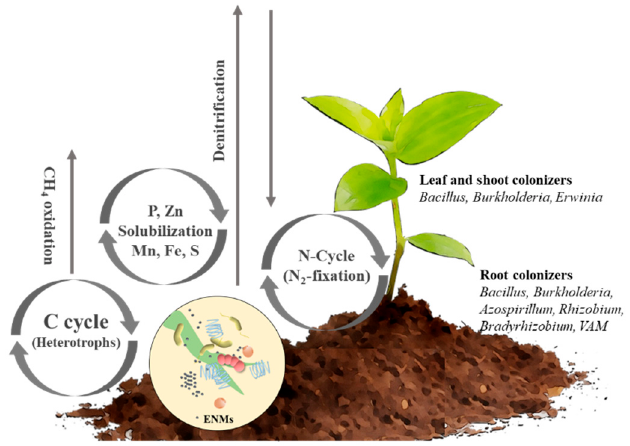
Figure 2. Versatile roles played by microorganisms in the geochemical cycling of nutrients.